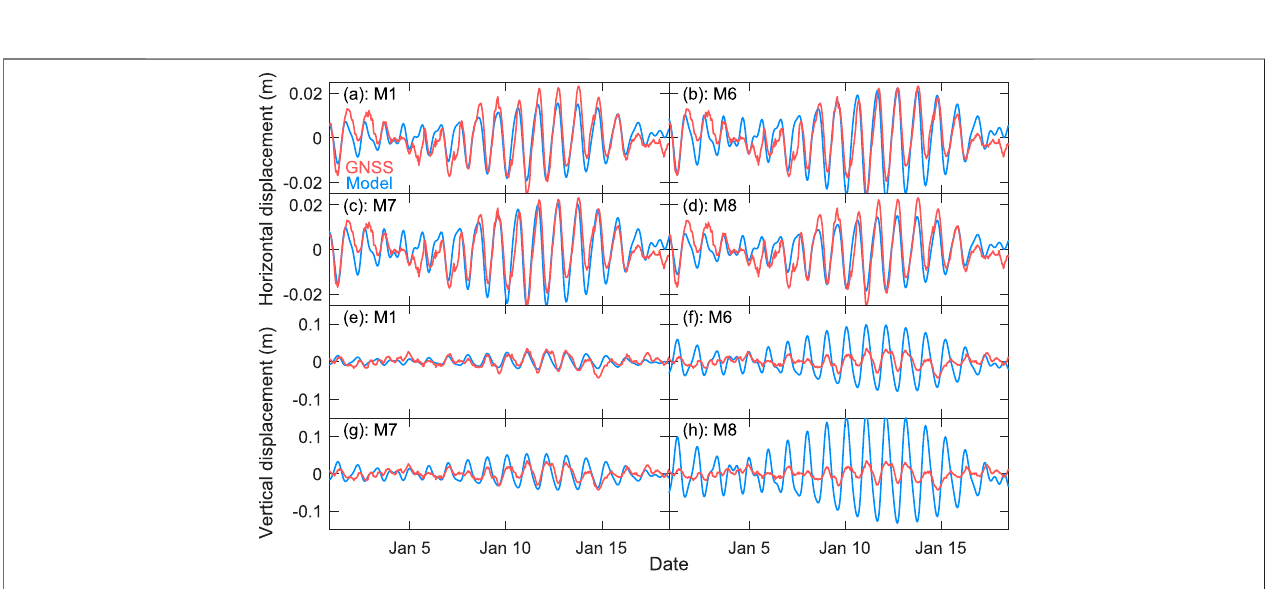
FIGURE 11 | Modelled versus GNSS – observed horizontal (across- fl ow) and vertical displacement for experiments M1, M6, M7, and M8.